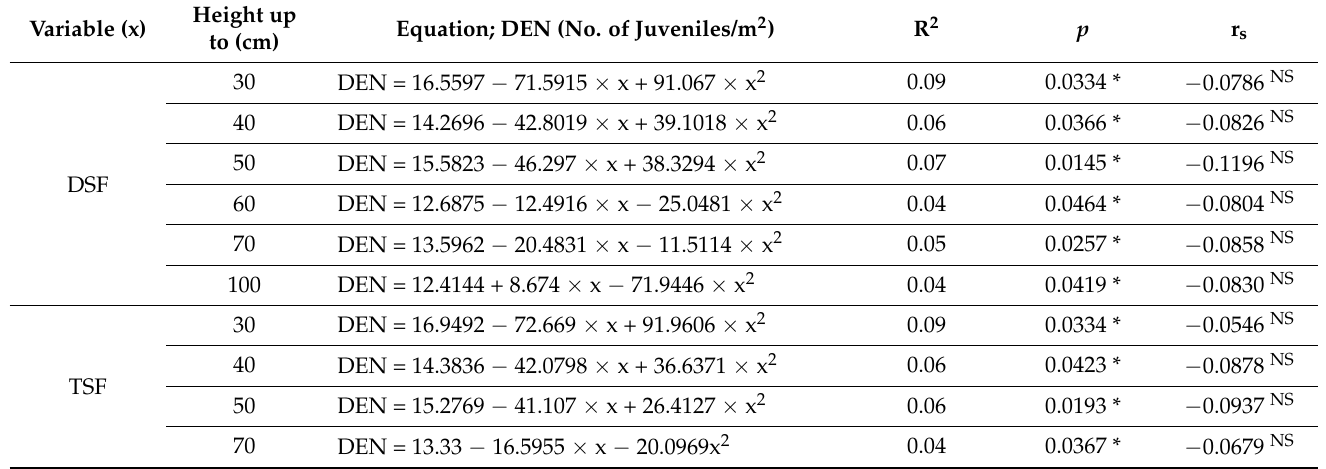
Table A1. Significant regression models of Norway spruce natural regeneration density and light